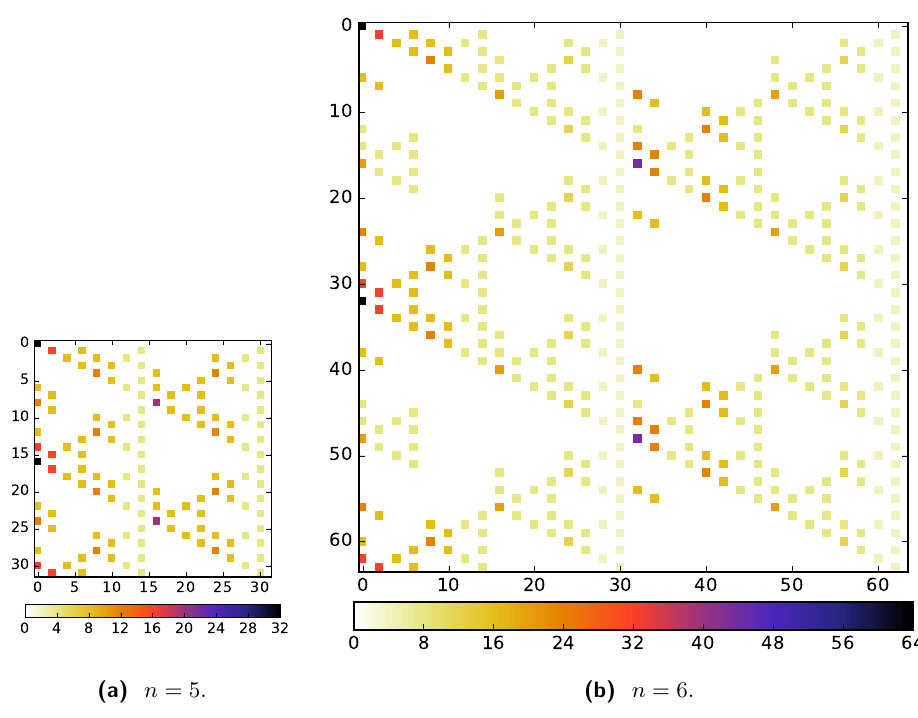
Figure 16: Difference distribution table of η : x 7→ A 3 ( x ) ⊕ x for different n